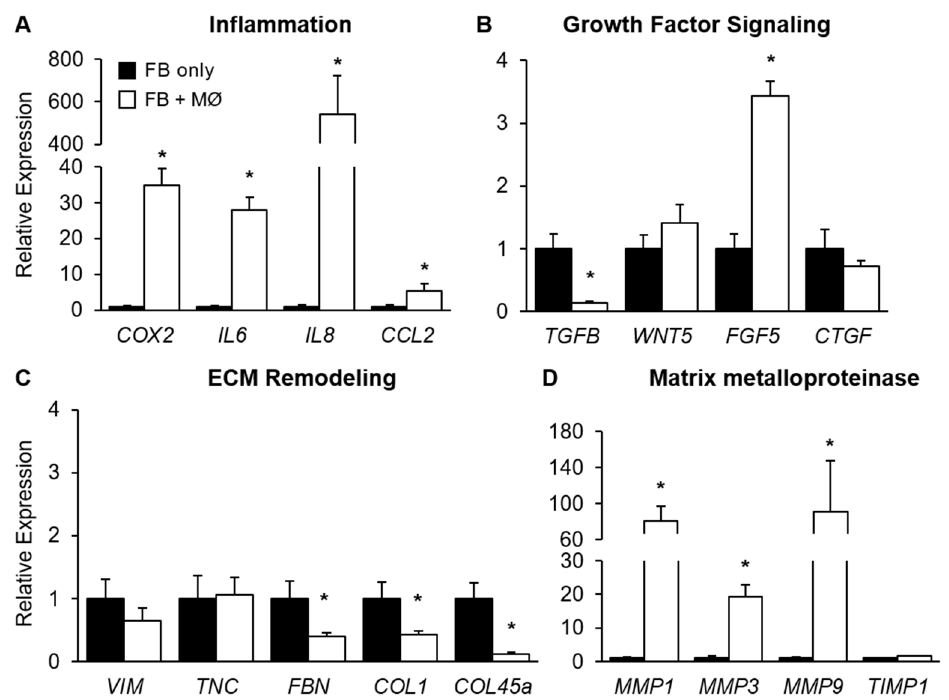
Figure 2. Gene expression in mammary fibroblasts following indirect co-culture with THP-1 derived macrophages. Primary mammary fibroblasts were cultured alone (FB only), or indirectly with PMA- treated THP-1-derived macrophages (0.5 × 10 6 cells/mL) (FB + MØ) for 72 h. Expression of genes associated with ( A ) inflammation, ( B ) growth factor signalling, ( C ) extracellular matrix remodelling, and ( D ) matrix metalloproteinase function were assessed through RT-PCR. Gene expression was normalised to the housekeeping gene HPRT1. Results are presented relative to fibroblasts-only cultures. All data mean + SEM. Statistical analysis was performed using a linear mixed effects model with Tukey’s post hoc comparison. Statistical significance is indicated by * when p < 0.05 .